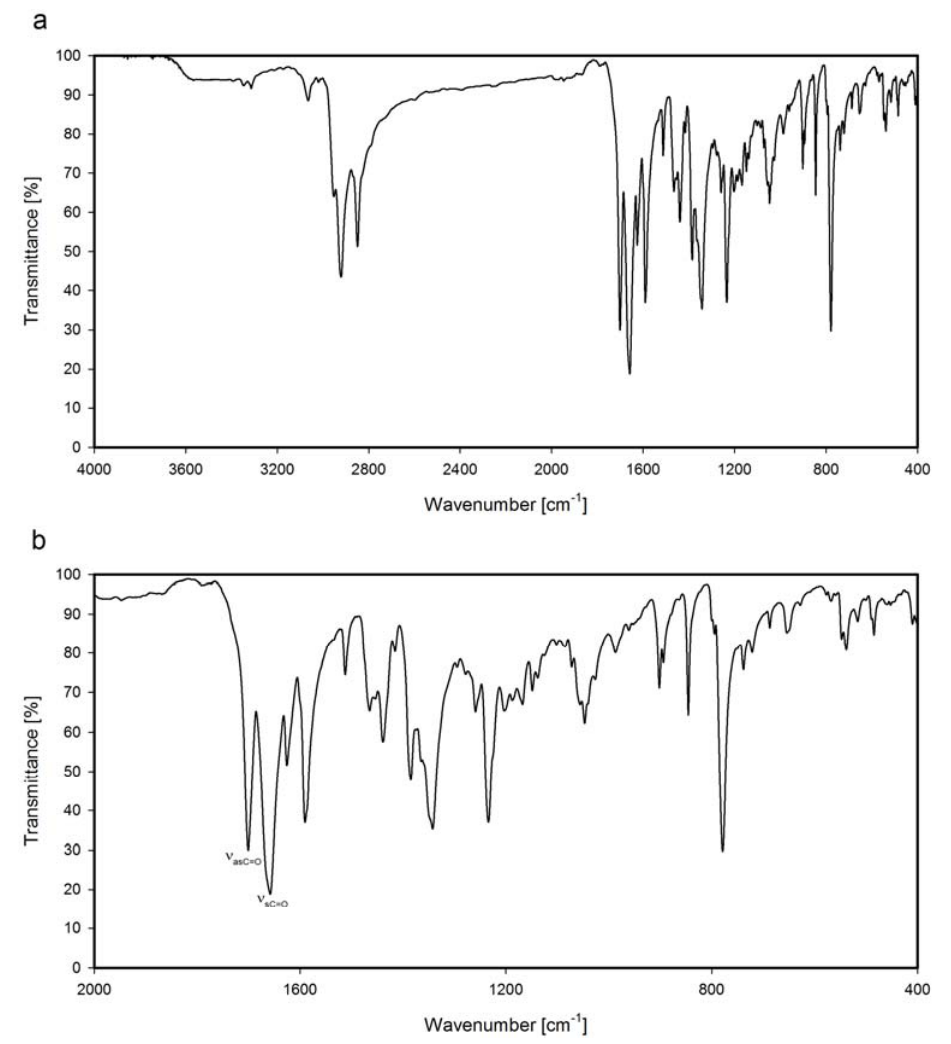
Figure 1. FTIR spectrum of N,N -bis[3-(1,8-naphthalimide)propyl]- N -dodecylamine ( NP4 ); ( a ) range 4000–400 cm − 1 ; ( b ) range 2000–400 cm − 1